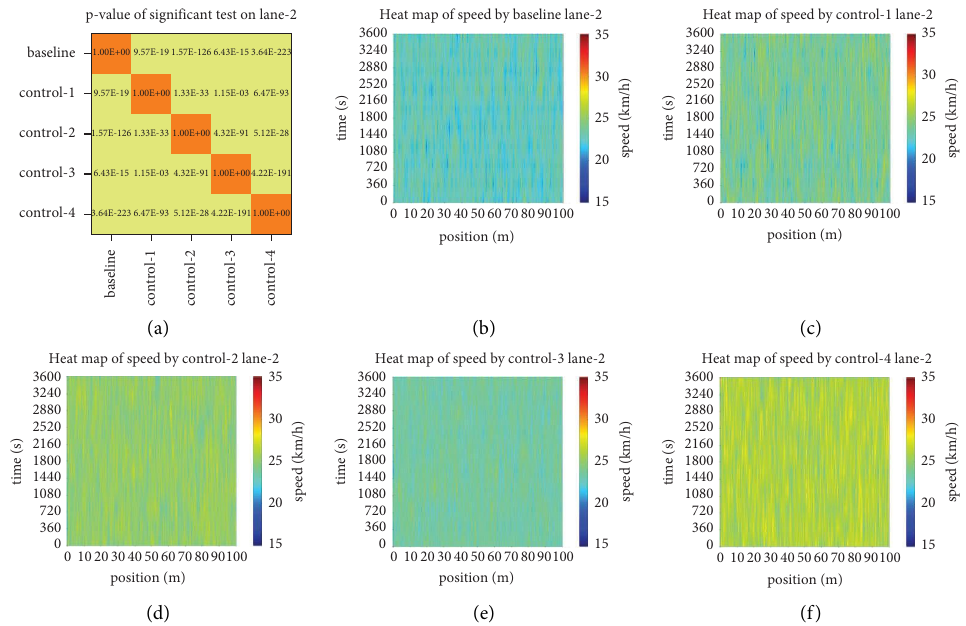
Figure 10: Heat maps of vehicle speed distributions under diferent control strategies and t -test results in lane-2. (a) T -test p value matrix. (b) Baseline (no controls). (c) Control-1 strategy (channelization left-right). (d) Control-2 strategy (channelization right-left). (e) Control-3 strategy (ramp metering). (f) Control-4 strategy (channelization and ramp